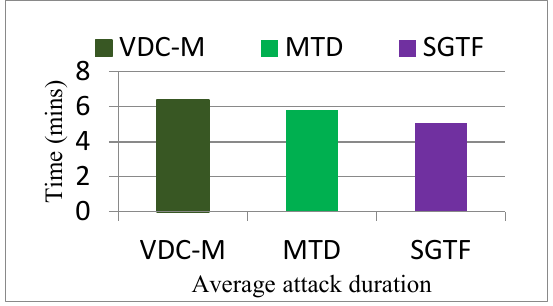
Figure.8. Average attack duration comparison between proposed and existing techniques